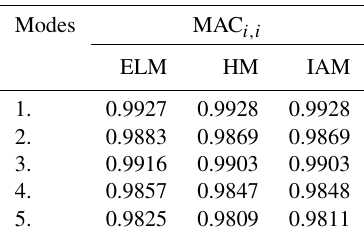
Table 10. Comparison of the modal assurance criterion (MAC) be- tween test results and simulation